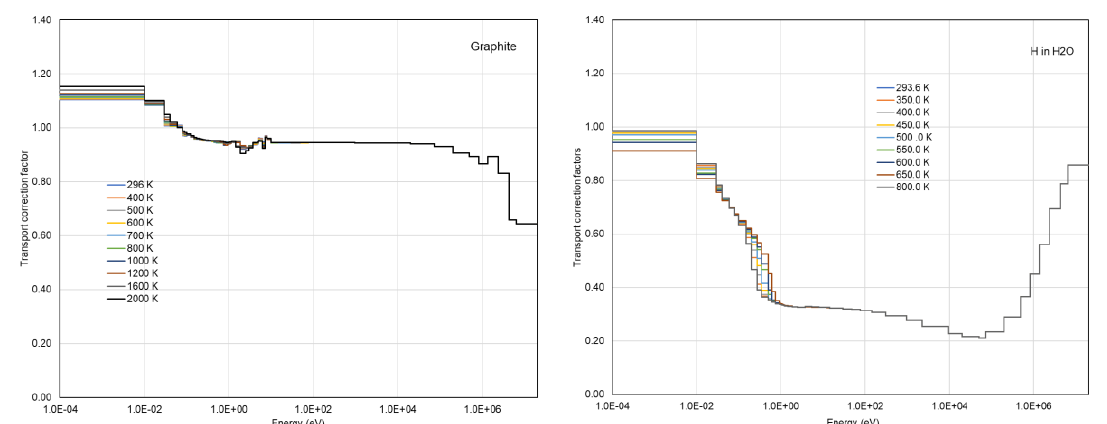
Figure 4. Transport correction factors for graphite and 1 H in H